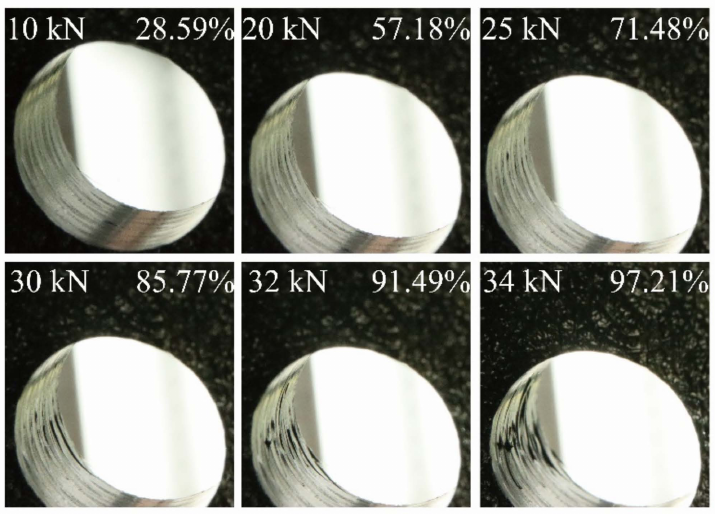
Figure 15. The experimental damage process at the open-hole region of the CY-4-01 specimen.